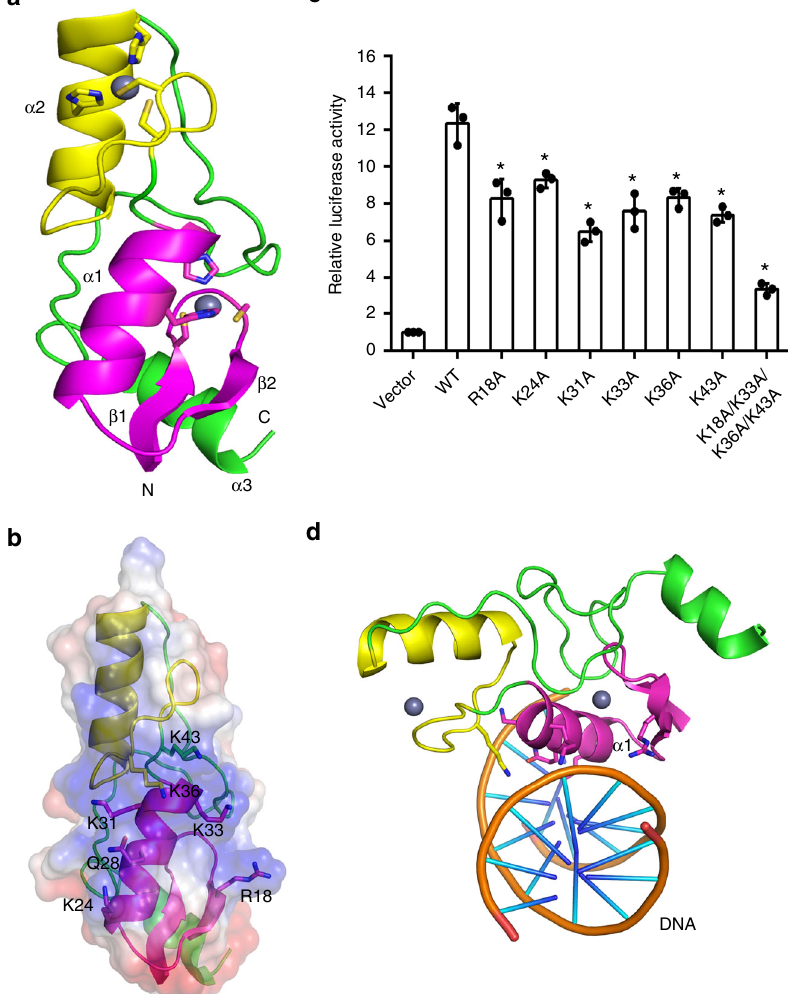
Fig. 8 Identi fi cation of residues crucial to the function of OsSUF4. a Overall structure of OsSUF4. The fi rst and second zinc fi nger domains are shown in magenta and yellow, respectively. Zinc ions are shown as gray spheres. b The detailed orientations of R18, K24, K31, K33, K36, and K43 within the fi rst zinc fi nger domain of OsSUF4. c Dual luciferase assay showing Hd3a promoter activation by wild-type or mutated OsSUF4. Relative luciferase activity refers to normalization of fi re fl y luciferase activity to the renilla luciferase activity as the internal control, then normalization to the vector (set as 1). Values are the mean ± SD of three independent biological replicates. Asterisks indicate signi fi cant differences between WT and mutants (Student ’ s t -test: * P < 0.01). d The proposed OsSUF4 – DNA-binding model. The fi rst zinc fi nger domain of OsSUF4 is proposed to contact DNA via positively charged residues from the major groove side. Source data are provided as a Source Data fi